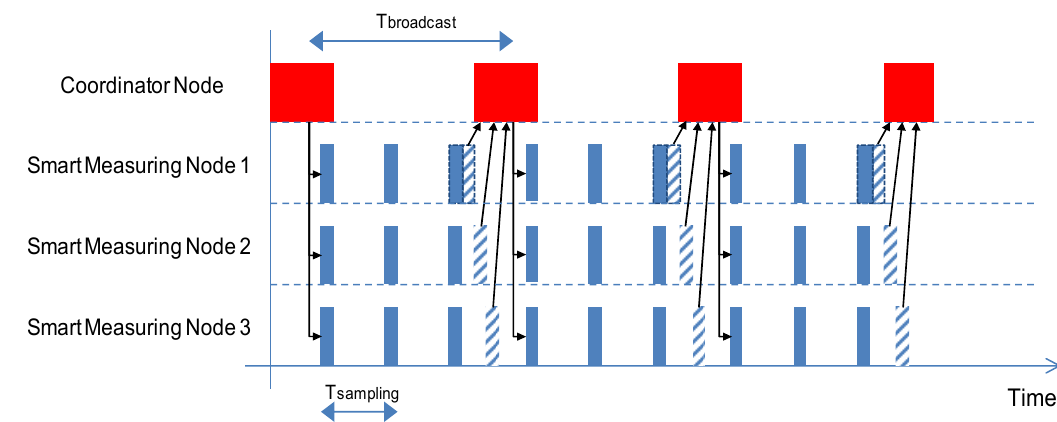
Figure 6. Chronogram for distributed monitoring operation. Processing of the nodes and exchanged messages when multiple sampling operation is used.